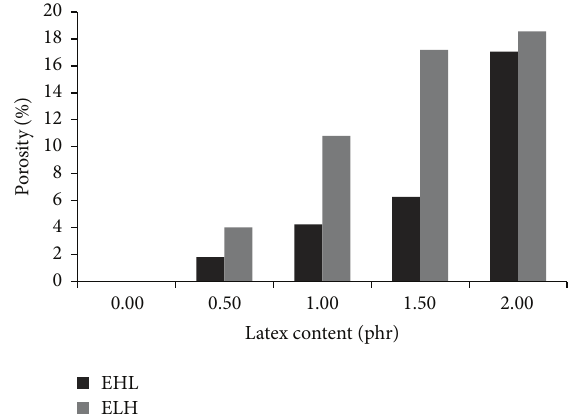
Figure 1: Porosity % of porous epoxy extracted by toluene using mixing sequence of EHL and ELH, respectively.